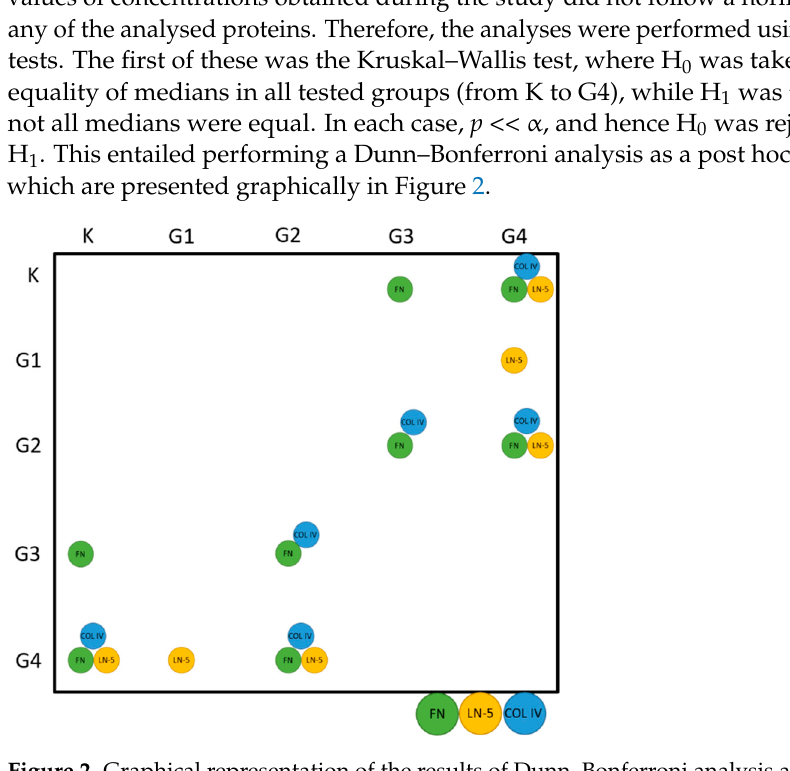
Figure 2. Graphical representation of the results of Dunn–Bonferroni analysis as a post hoc test.